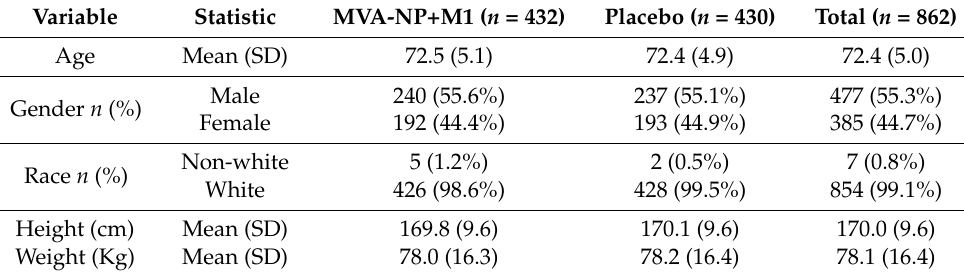
Figure 1. CONSORT Diagram showing patient screening and flow. ITT- intention to treat. Table 1. Summary of Demographics (ITT Population).